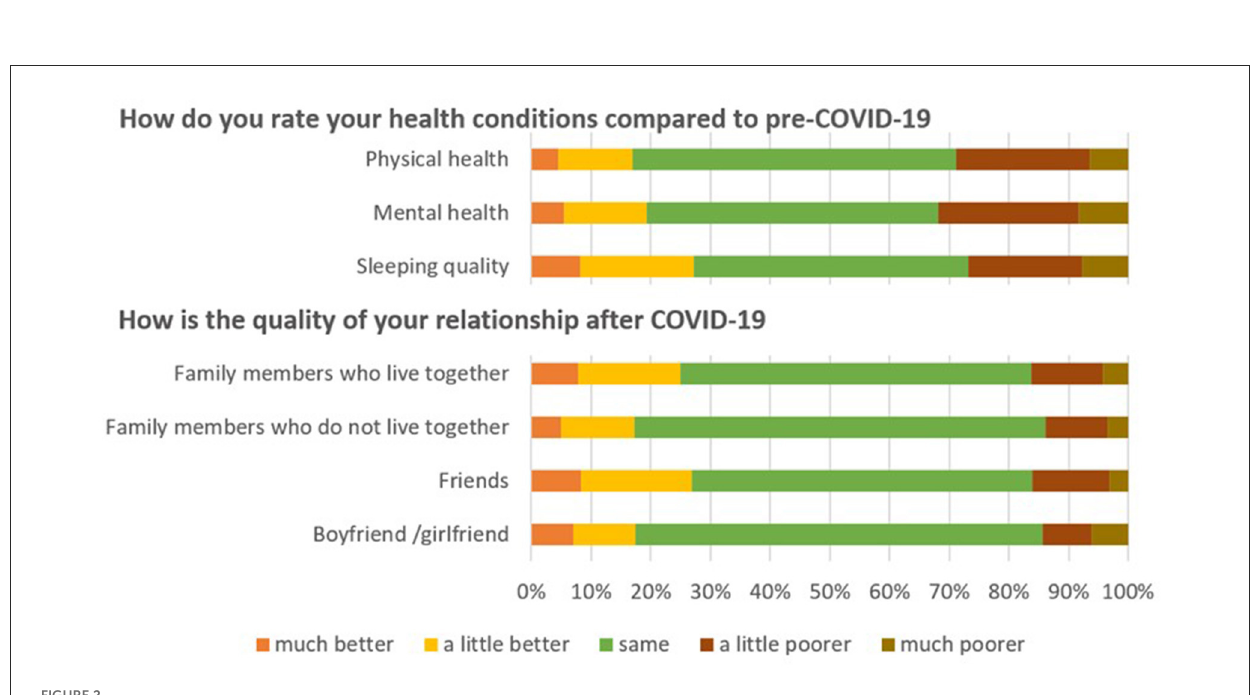
FIGURE2 The effect of COVID-19 on the participants’